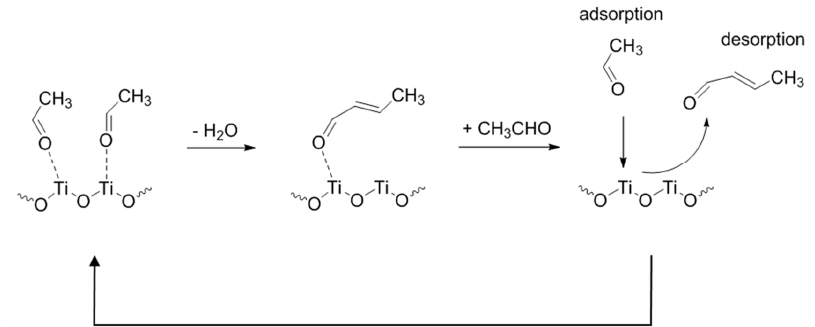
Figure 4. Adsorption and reaction of acetaldehyde on the anatase surface, in the dark. Acetaldehyde molecules were adsorbed on the TiO 2 surface and reacted, via an aldol condensation, to the crotonaldehyde. Crotonaldehyde was desorbed from the surface and was replaced by new acetaldehyde molecules, which further reacted with each other.